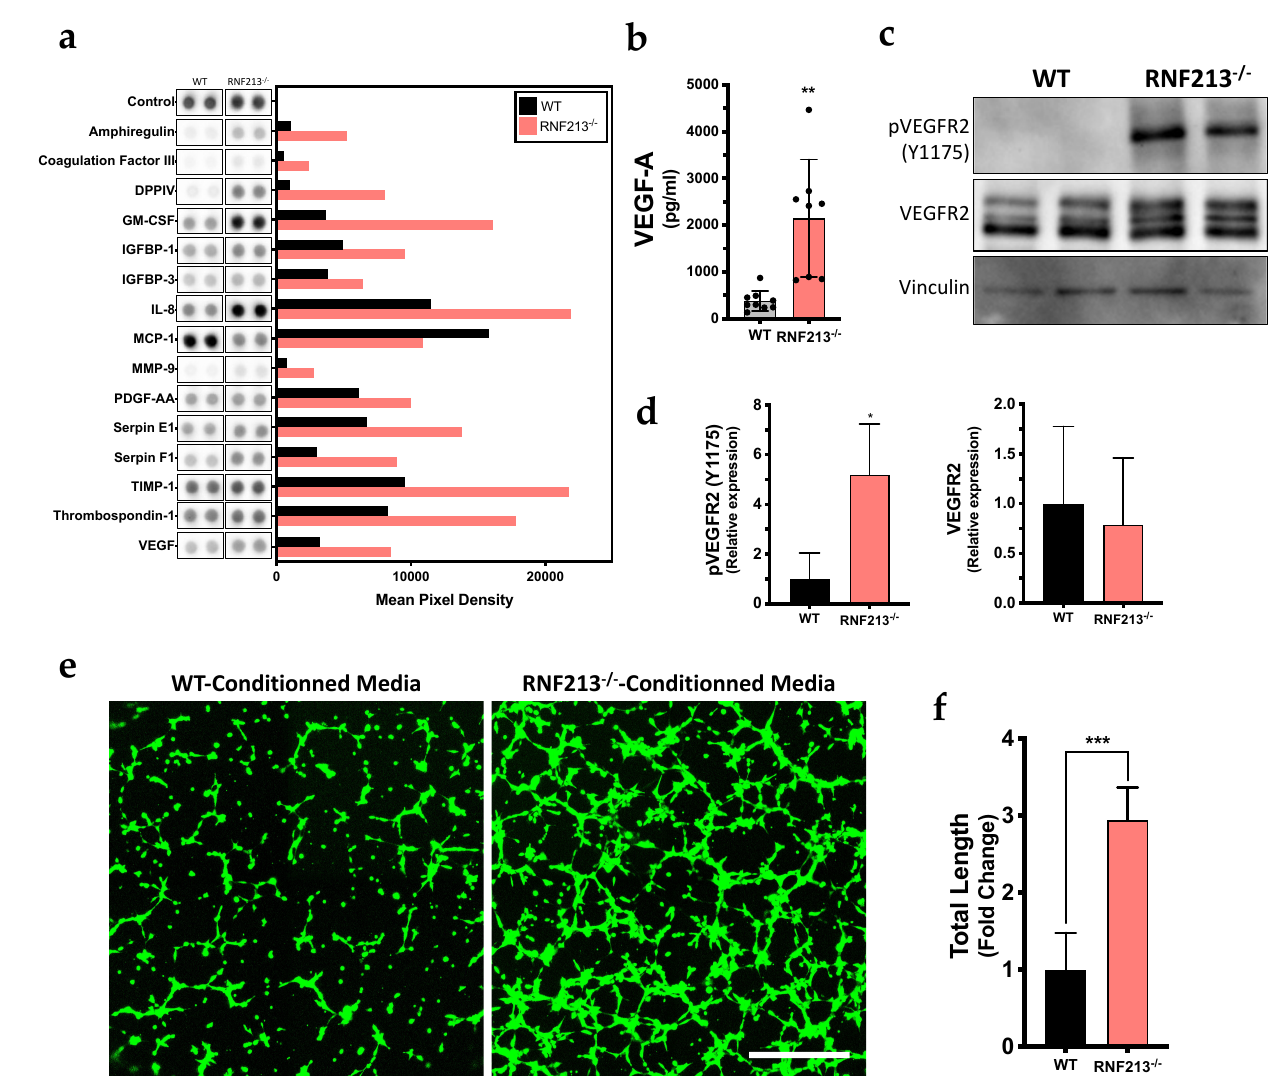
Figure 4. RNF213 invalidation enhanced the secretion of pro-angiogenic factors. ( a ) Profiling of the angiogenic secretome of hCMEC/D3 monolayer using the human angiogenesis proteome arrays. The duplicate spots corresponding to the most altered proteins are shown. Mean pixel intensity was normalized to the number of cells present in the well at the moment of the supernatant recovery. n = 2; ( b ) ELISA for secreted VEGF-A. Total proteins concentration is shown in pg/mL of conditioned media and are normalized to the number of cells. n = 8; ( c ) Western blot analysis of the receptor VEGFR2 and the phosphorylation levels of Tyr 1175 in hCMEC/D3-RNF213 − / − and the WT control cultured at confluency. Vinculin was used as a loading control; ( d ) Densitometry analysis of the total VEGFR2 and the phosphorylation levels. Total VEGFR2 levels are normalized to β -actin and shown to the relative intensity of the WT control. The phosphorylated form of VEGFR2 was normalized to total VEGFR2. n = 4; ( e ) Tube formation assay on Matrigel ® with conditioned media from hCMEC/D3 monolayer on hCMEC/D3-WT; ( f ) Quantification of the capillary-like networks total length reported in fold change relative to the control with WT conditioned media. n = 10. Scale bar = 500 µ m. * p < 0.05, ** p < 0.01 and *** p <